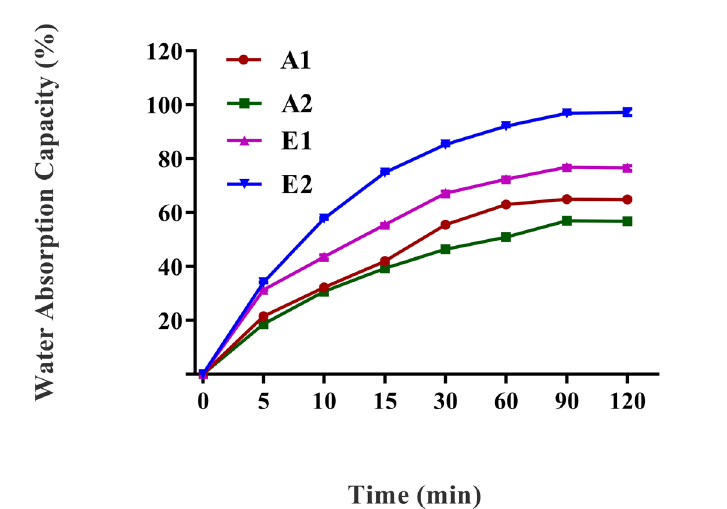
FIGURE 2 - The effects of the molecular weight of chitosan on the water absorption capacity of hydrogel formulations (n=3). A1 and A2 formulations include medium molecular weight chitosan, E1 and E2 formulations contain high molecular weight